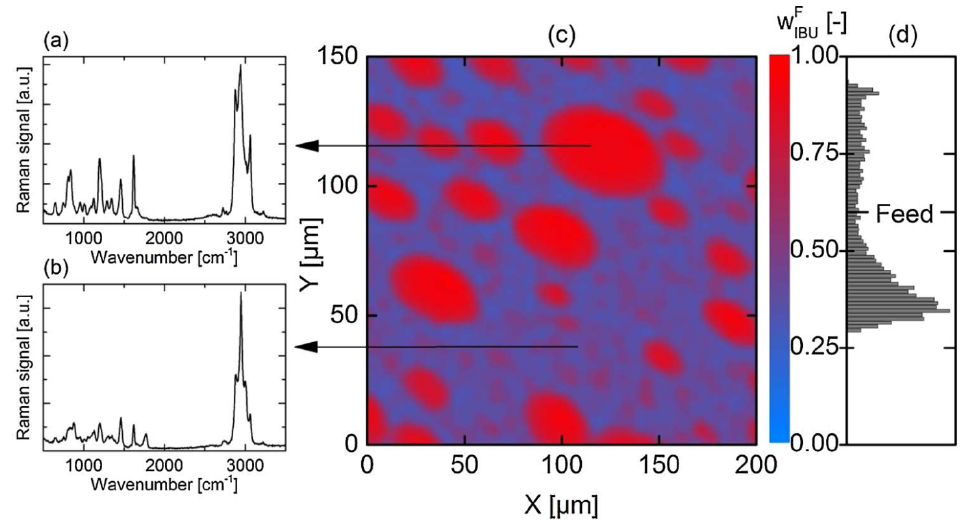
Figure 7. Raman mapping of ibuprofen–poly(lactic-co-glycolic acid) system containing 60 wt% ibuprofen. Raman spectra of drug-rich ( a ) and polymer-rich ( b ) regions. The obtained Raman map ( c ) and ibuprofen distribution from this Raman map ( d ). Adapted from Ref. [92] with permission. Copyright © 2018 Elsevier.